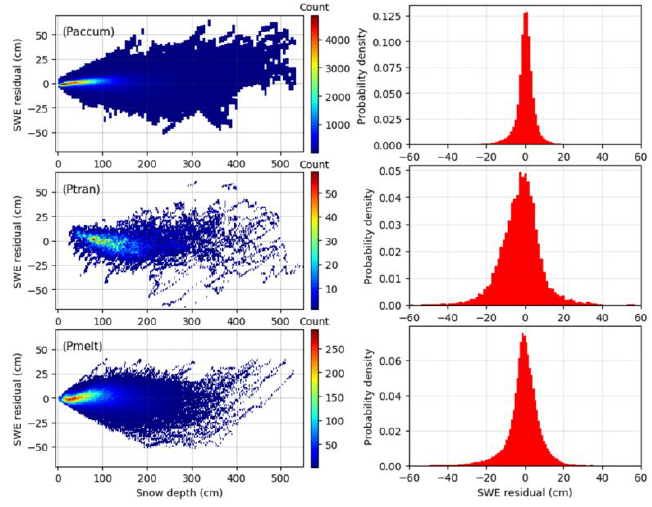
Figure 8. Heat map of the modeled SWE residuals versus the snow depth ( left ) and the residuals probability density ( right ) for the three periods.